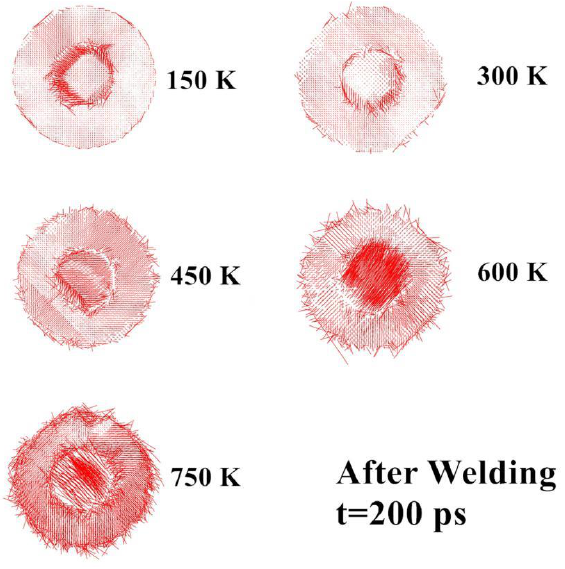
Figure 5. Radial distribution functions after the holding process under the different temperatures conditions (150, 300, 450, 600 and 750 K).